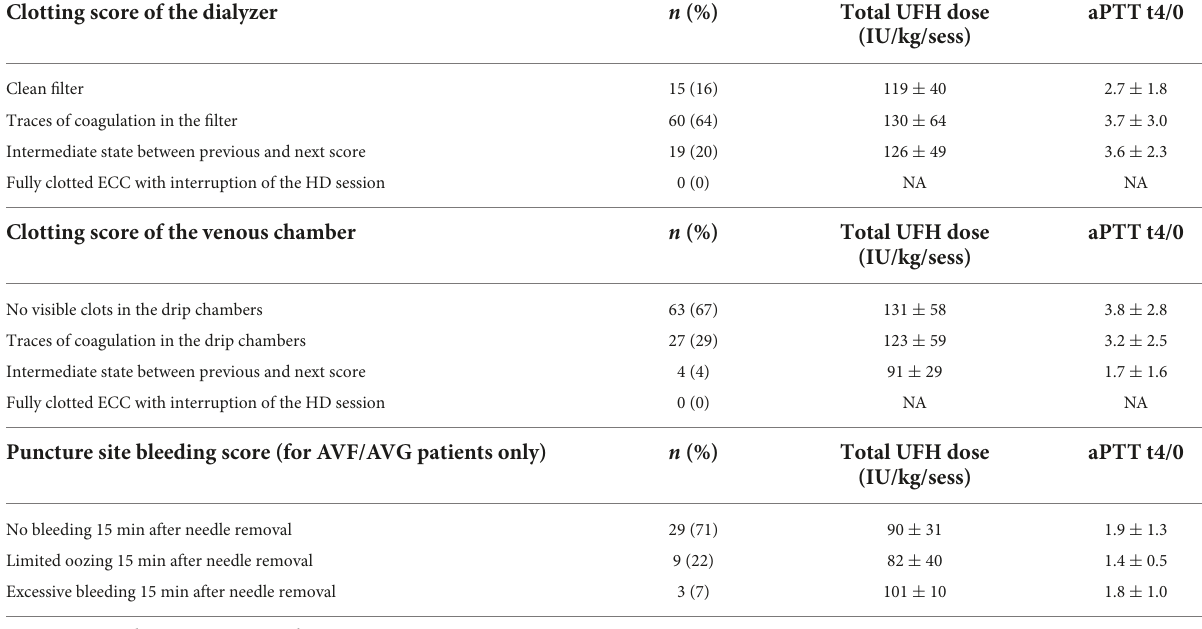
TABLE 6 Semiquantitative clotting scores of the extracorporeal circuit and the AV-access site after dialysis.